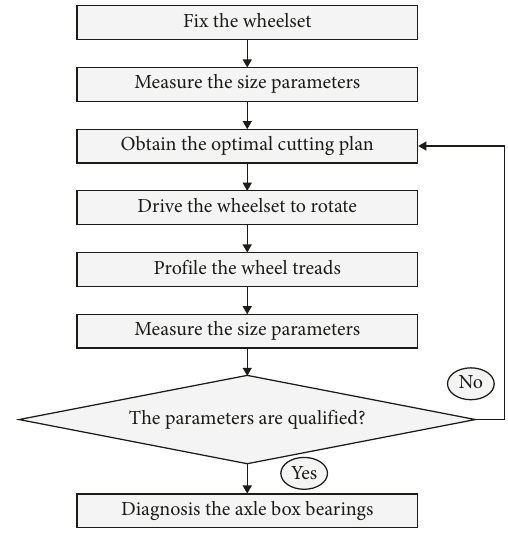
Figure 3: System